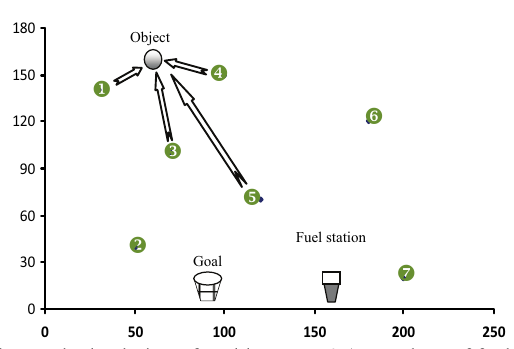
Fig. 6. Final solution of problem case 1 (second set of fuels) Fig. 7. Final solution of problem case 2 (second set of